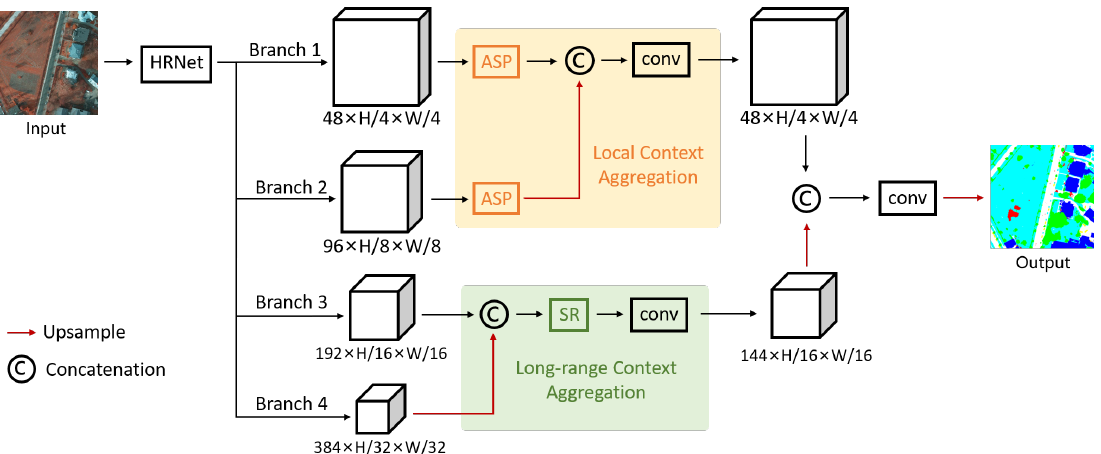
Figure 3. Overview of the proposed multi-scale context aggregation